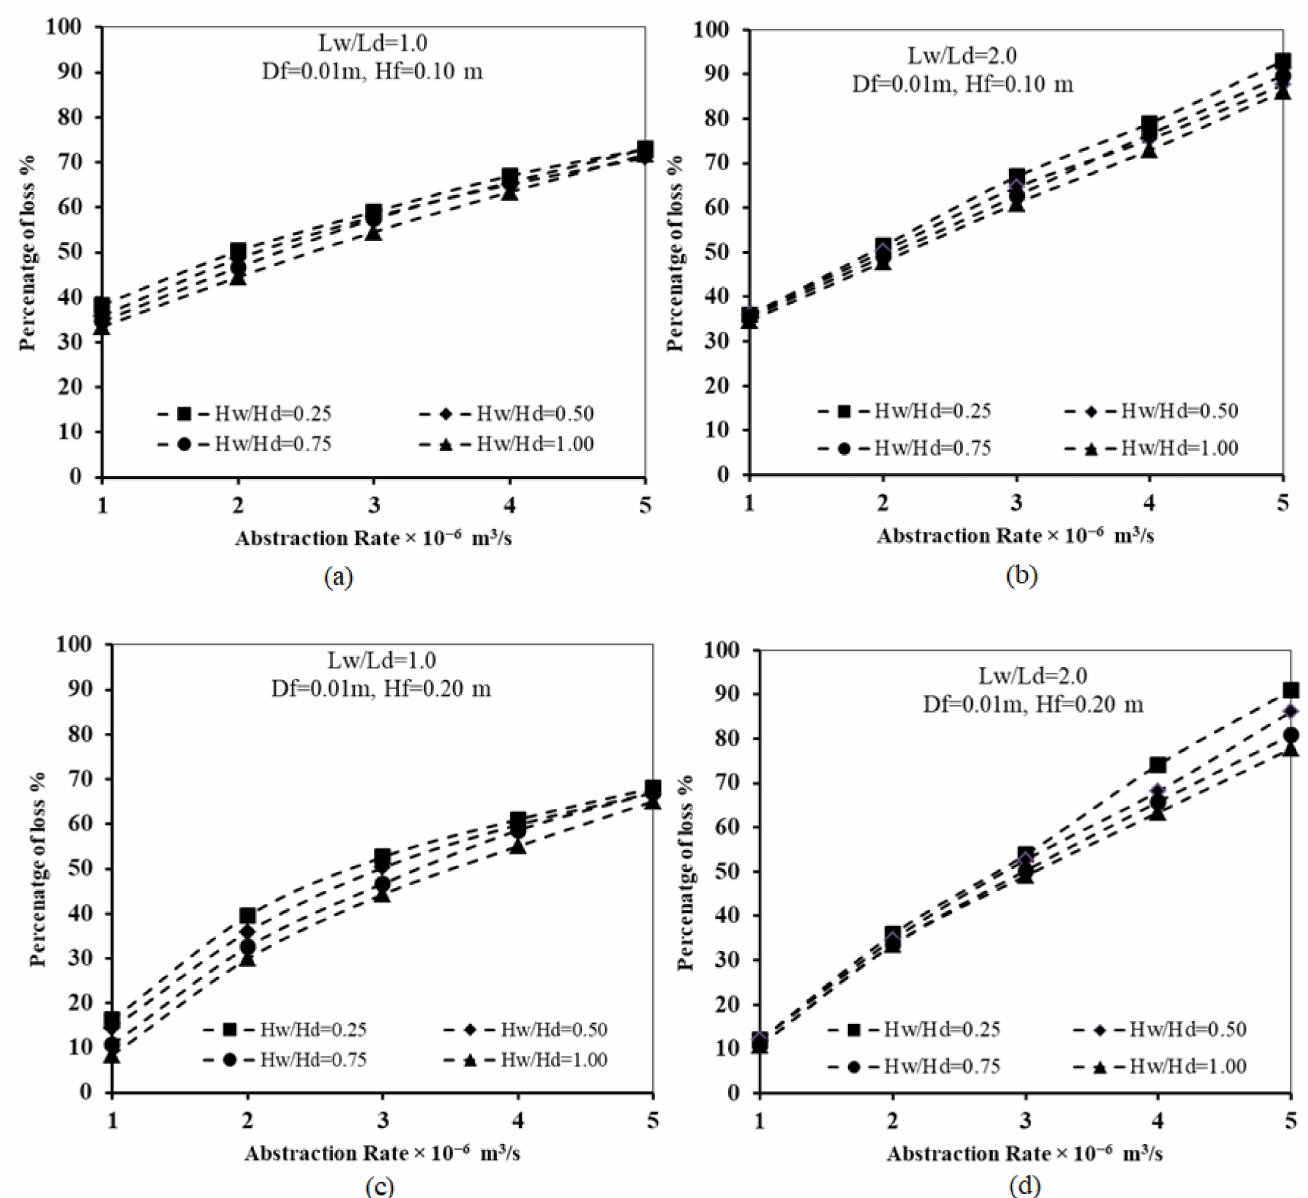
Figure 6. Relation between abstraction well rate and loss of subsurface dam effectiveness for L d = 0.50 m, D f = 0.01 m, and for different L w /L d and H f : ( a ) L w /L d = 1.0 and H f = 0.1, ( b ) L w /L d = 2.0 and H f = 0.1, ( c ) L w /L d = 1.0 and H f = 0.2, and ( d ) L w /L d = 2.0 and H f =